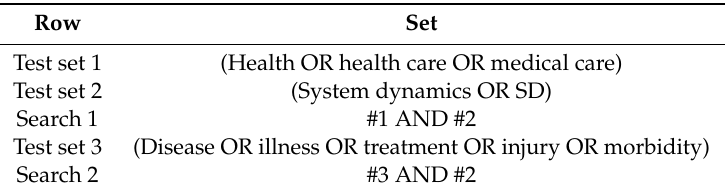
Table 2. The first set of keywords used in the present review.